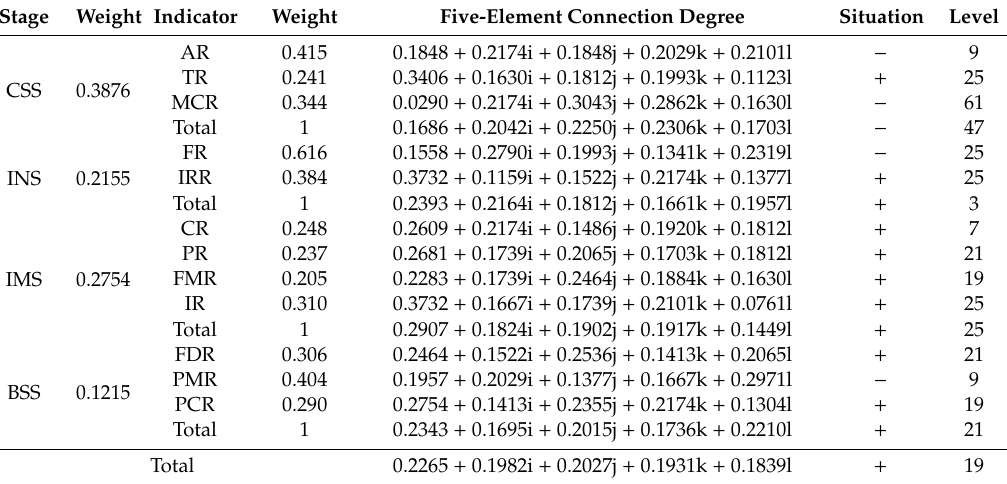
Table 5. Calculation table of the five-element connection